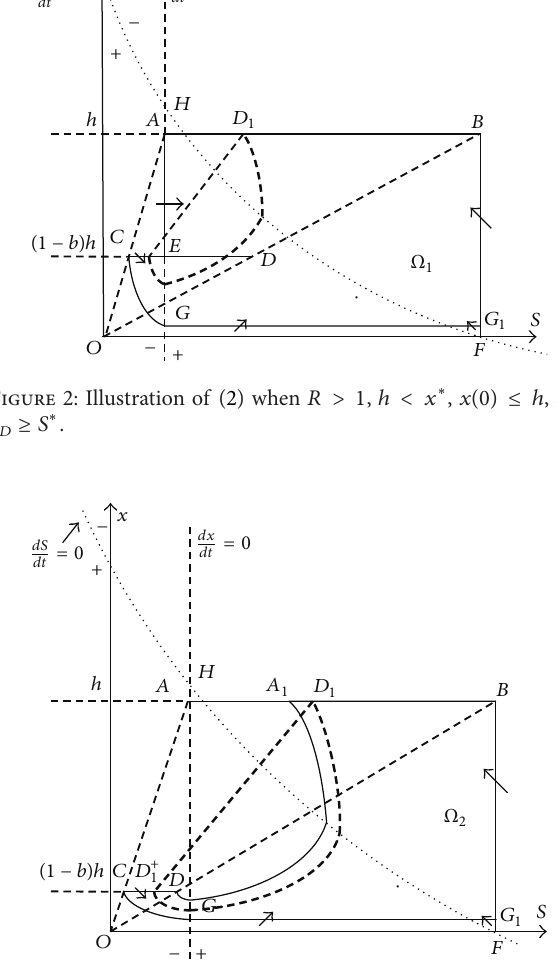
Figure 3: Illustration of (2) when 𝑅 > 1 , ℎ < 𝑥 ∗ , 𝑥(0) ≤ ℎ , and < 𝑆 ∗ 𝑆 𝐷